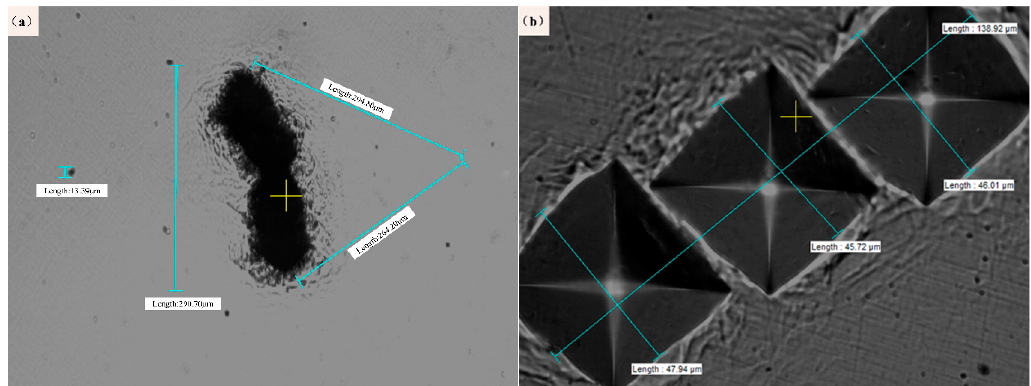
Figure 2. Locations for indentation and inclusions under di ff erent magnifications: ( a ) inclusions and indentation position under 20 × magnification and ( b ) standard indentation under 50 ×